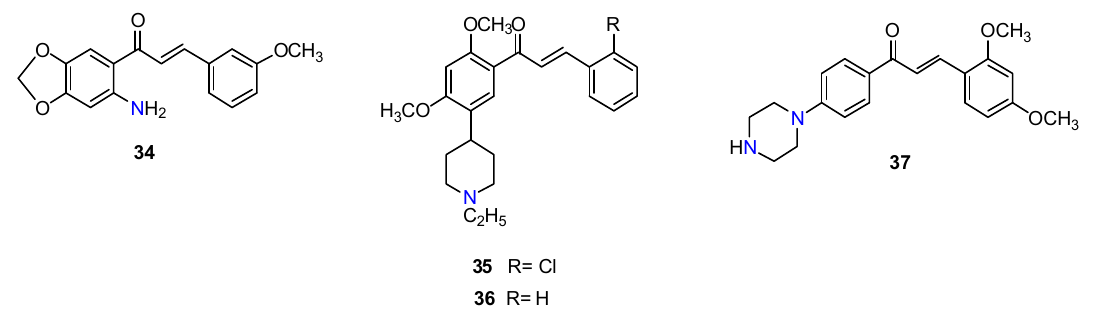
Figure 8. Chalcone derivatives 34 – 37 .